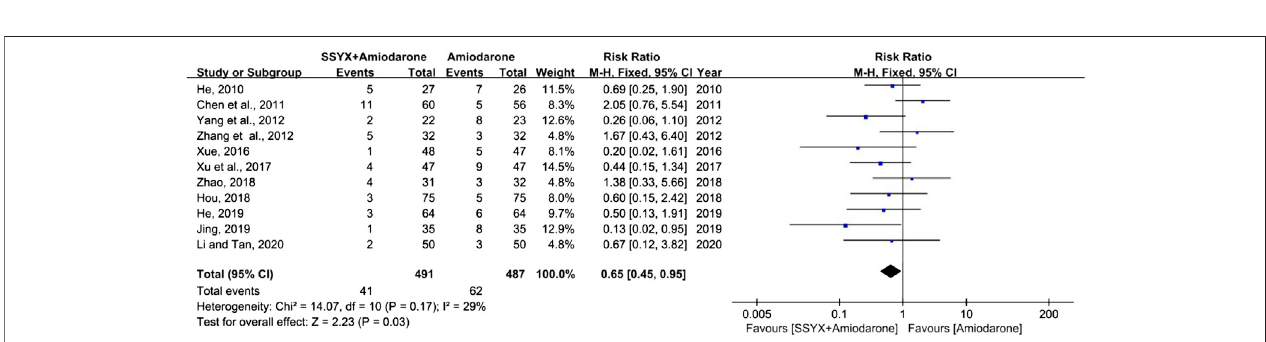
FIGURE 4 | Forest plot of comparison: SSYX-amiodarone vs. amiodarone alone: ADRs.